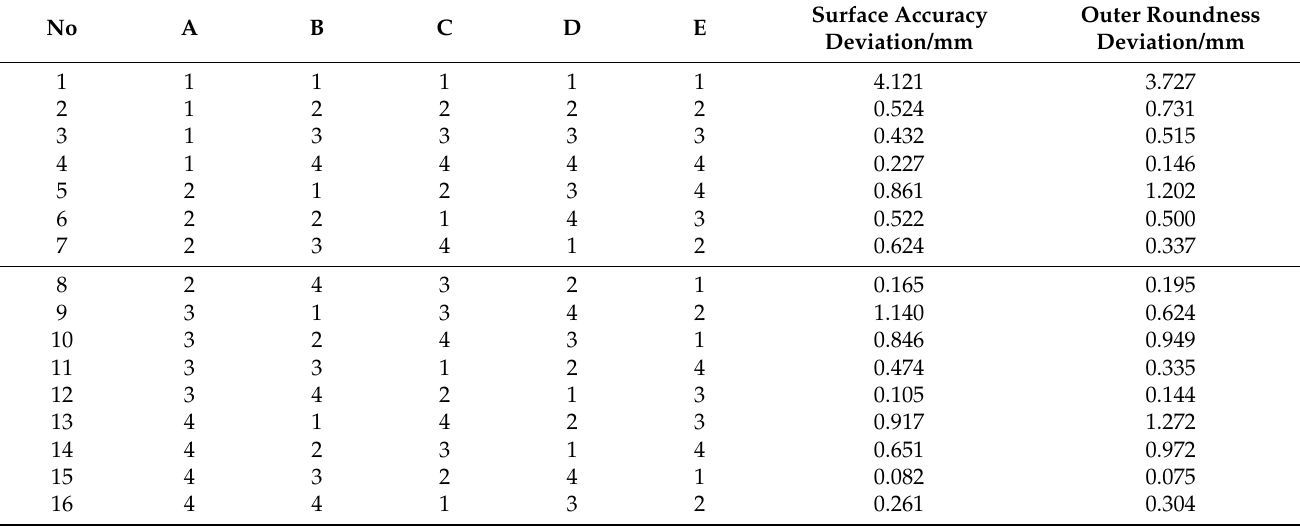
Table 4. Test arrangements and